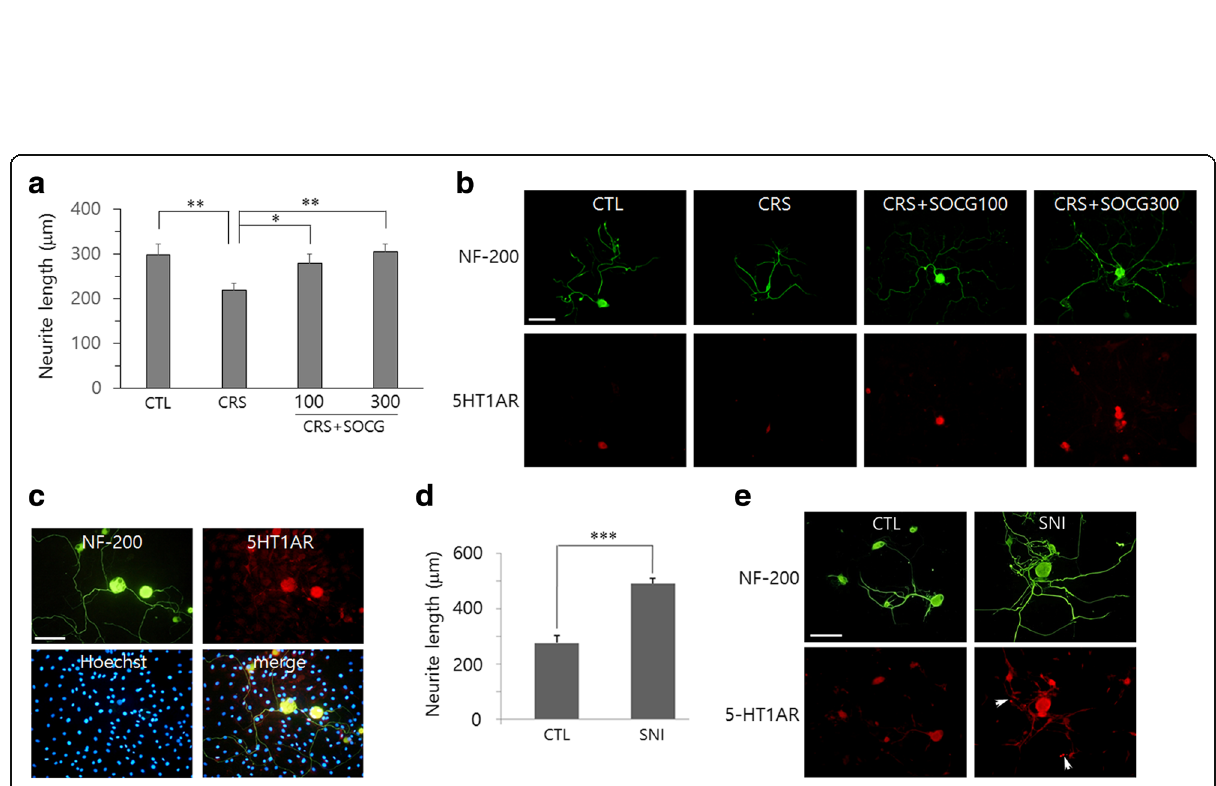
Fig. 5 Effects of SOCG treatment on the neurite outgrowth of DRG neurons. a - c . DRG at lumbar 4 and 5 were prepared from animals from 4 experimental groups. Neuritic processes of cultured DRG neurons were visualized by NF-200 staining (in green) and quantified ( a ). Representative images of DRG neurons for 4 experimental groups ( b ), and those from CRS + SOCG300 group ( c ). d - e . DRG neurons, which were prepared from the animal given sciatic nerve preinjury (SNI), were used for immunofluorescence staining with anti-NF-200 and anti-5-HT1AR antibodies. *P < 0.05; **P < 0.01 (One-way ANOVA, n = 4). All scale bars in ( b ), ( c ) and ( e ): 100 μ